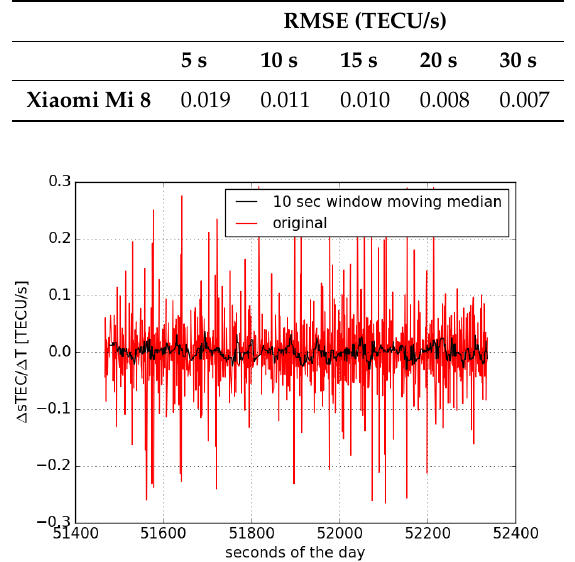
Figure 14. The trends of the original E13 Xiaomi Mi8 ∆ sTEC / ∆ t series and after using a 10 s window moving median are respectively depicted in red and